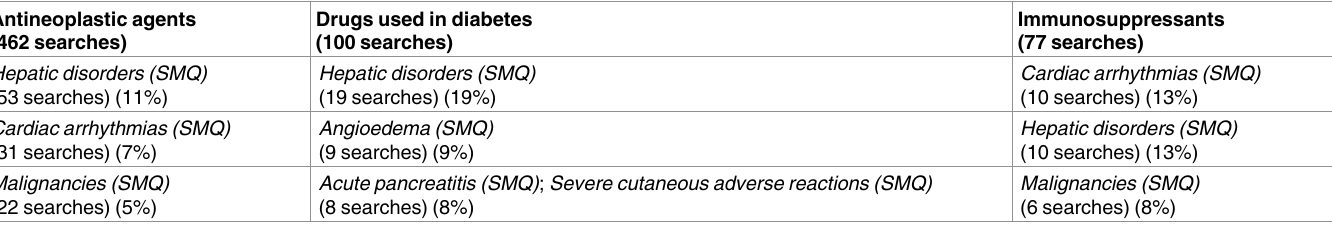
Table 2. Distribution of the top three most frequently searchedSMQs for the top three therapeutic classesrepresentedby the second level of the ATC classification system a,b . Antineoplastic agents (462